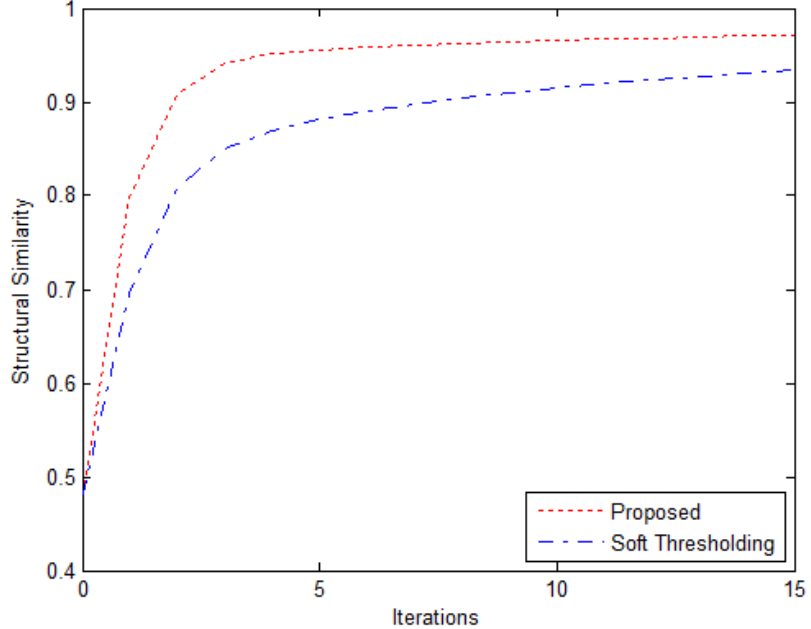
Figure 8. Structural Similarity of proposed and soft thresholding algorithm for recovery of compres- sively sampled MR image against each iteration.